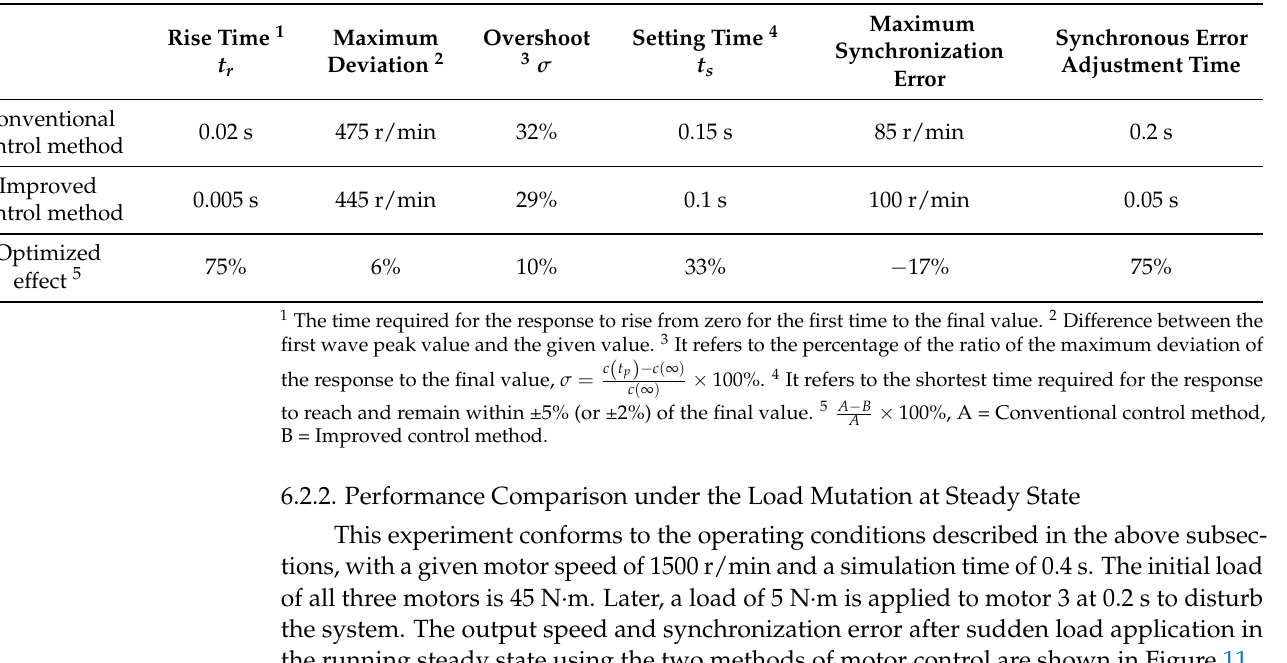
Figure 10. Performance comparison of startup performance between conventional and improved control methods. Table 2. Control system performance